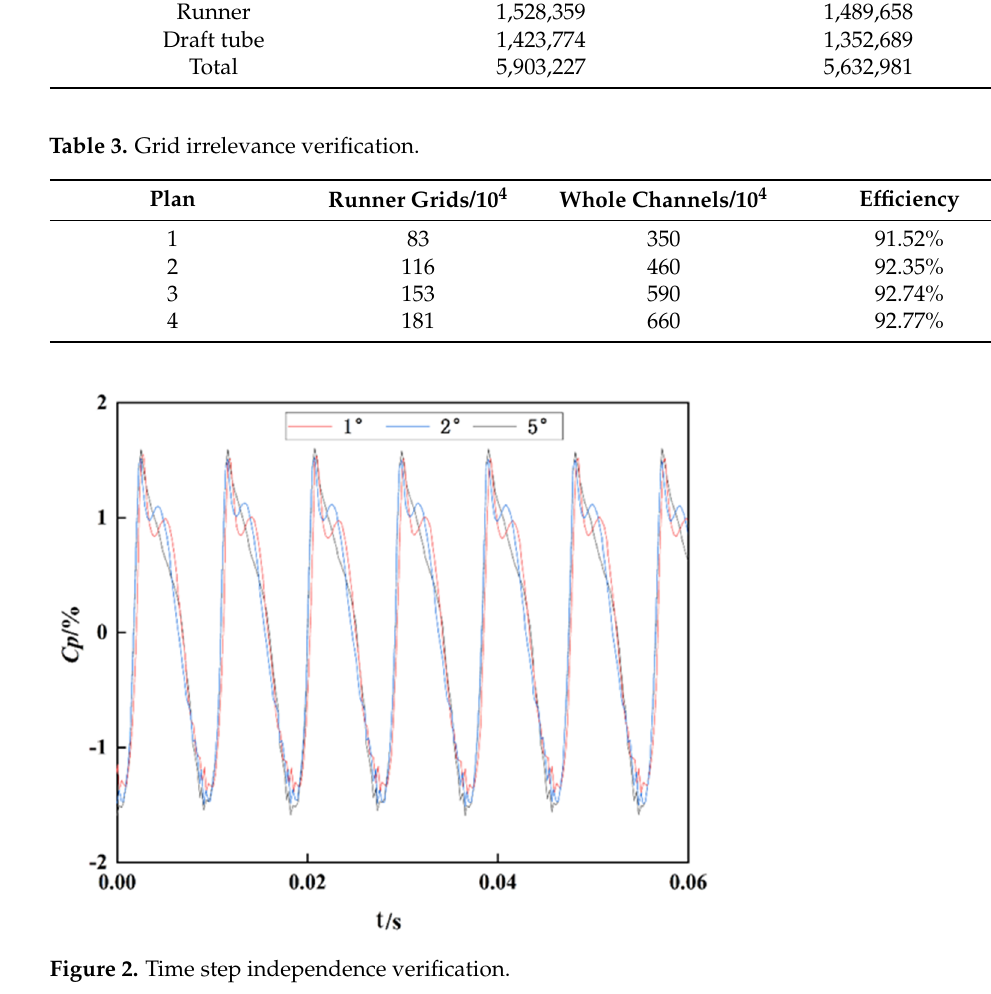
Table 2. Number of grids and nodes.